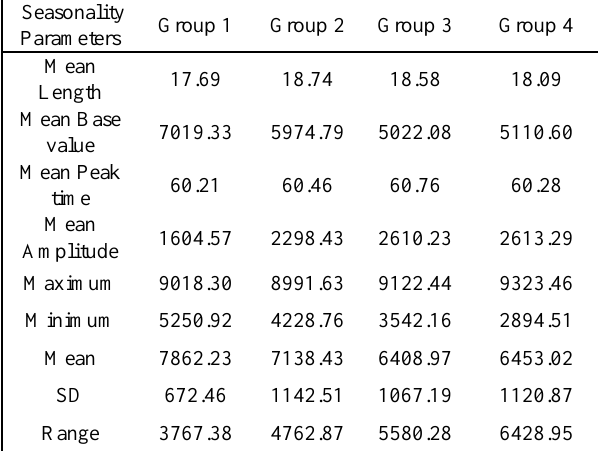
Table 2. Seasonality parameters for each group with different textural